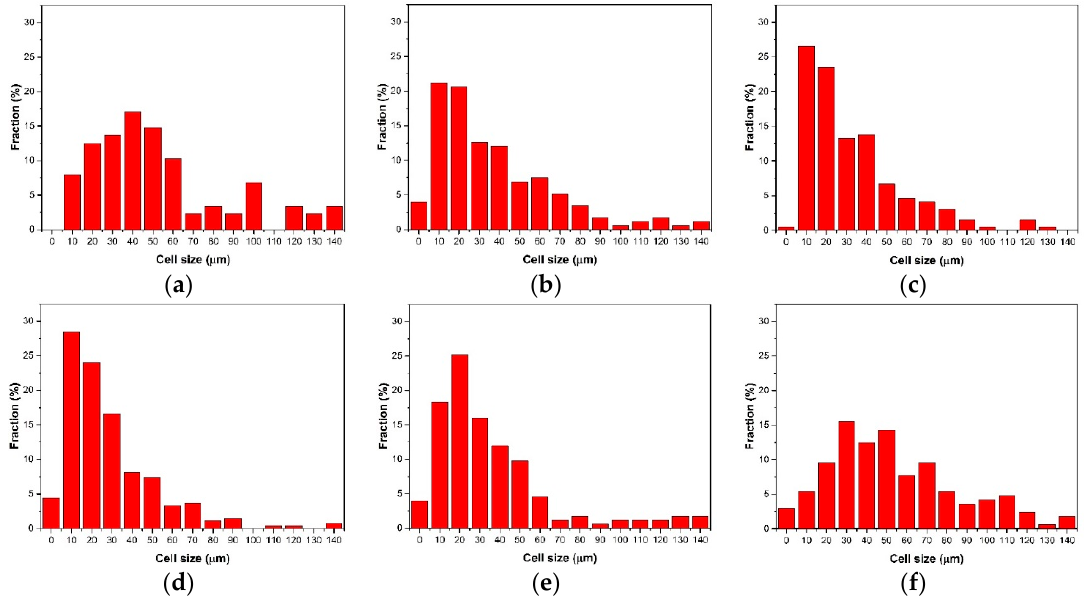
Figure 11. The cell size distribution of the core layer of the vertical sections with different contents of nano ‐ CaCO 3 : ( a ) 0 wt %; ( b ) 2 wt %; ( c ) 4 wt %; ( d ) 6 wt %; ( e ) 8 wt %; ( f ) 10 wt %. The average cell diameter and cell density can be calculated with Image Pro Plus. The results of the average cell diameter and cell density are shown in Figure 12.